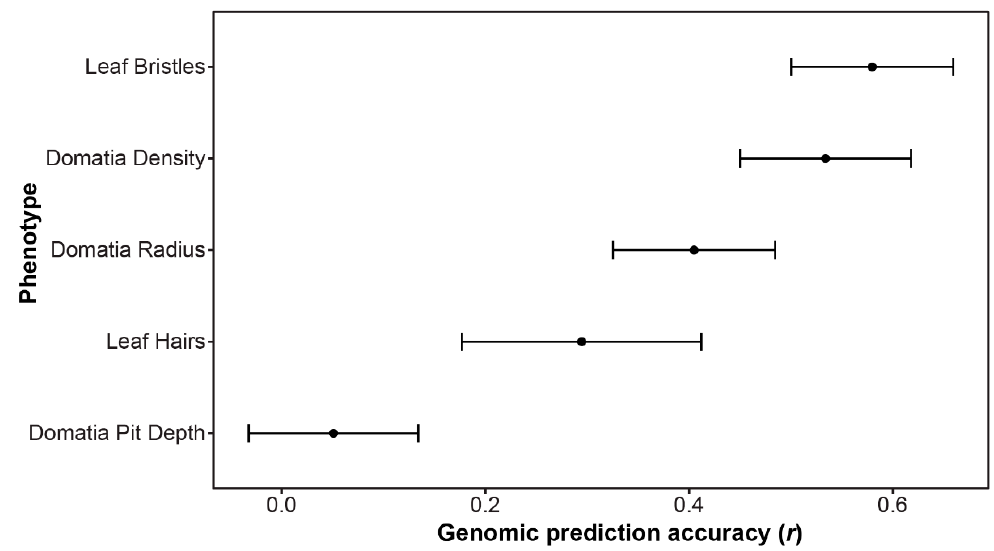
Figure 5. Genomic prediction accuracy ( r ), indicating the correlation between the observed and prediction phenotype, as estimated using an rrBLUP model with fivefold cross-validation, repeated three times. The average r ± the standard deviation is plotted.